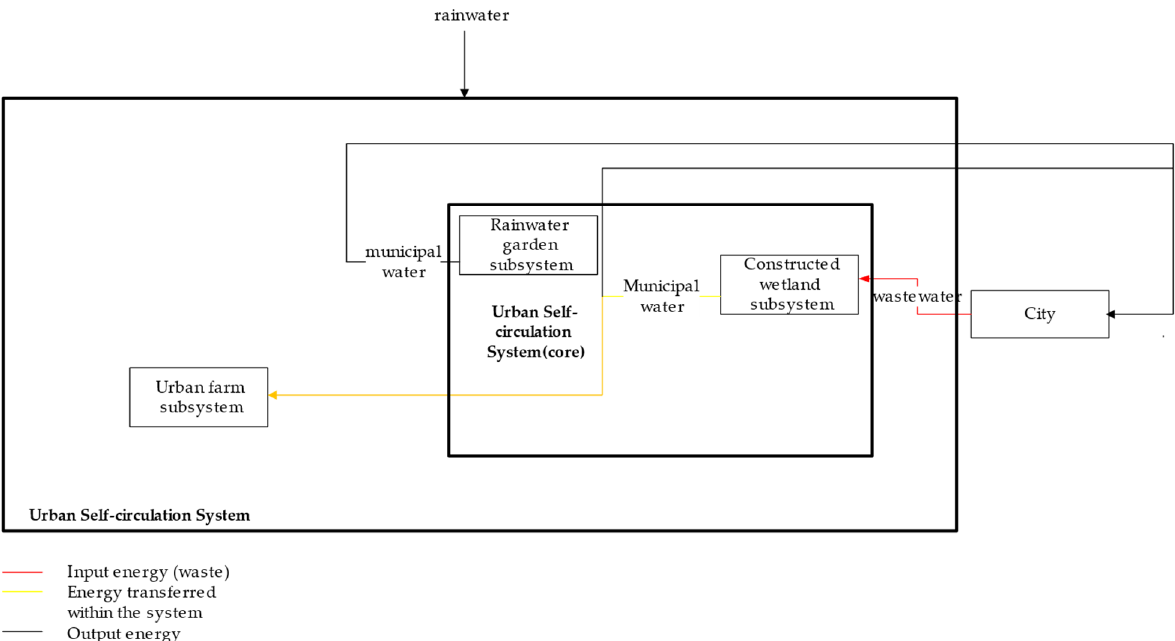
Figure 3. Flows of Water and Derivatives.